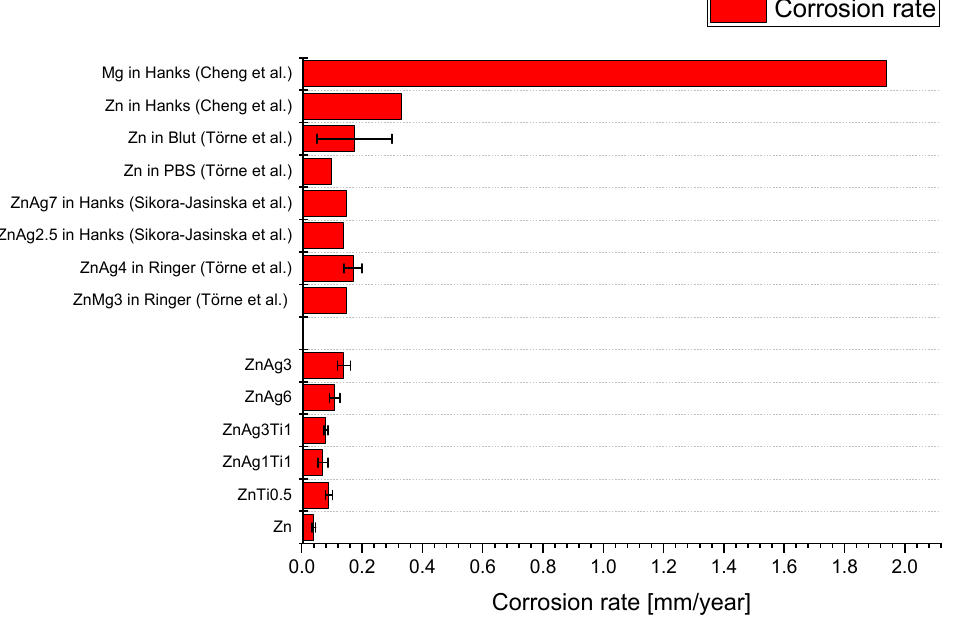
Figure 7. Corrosion rates of zinc and zinc alloys measured in electrochemical corrosion testing in different media [21,22,30,31].